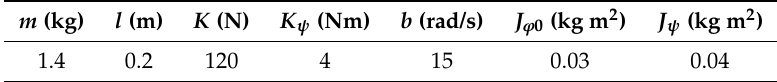
Figure 4. The Qball-X4 quadrotor UAV test platform. Table 2. The Qball-X4 quadrotor UAV dynamic parameters